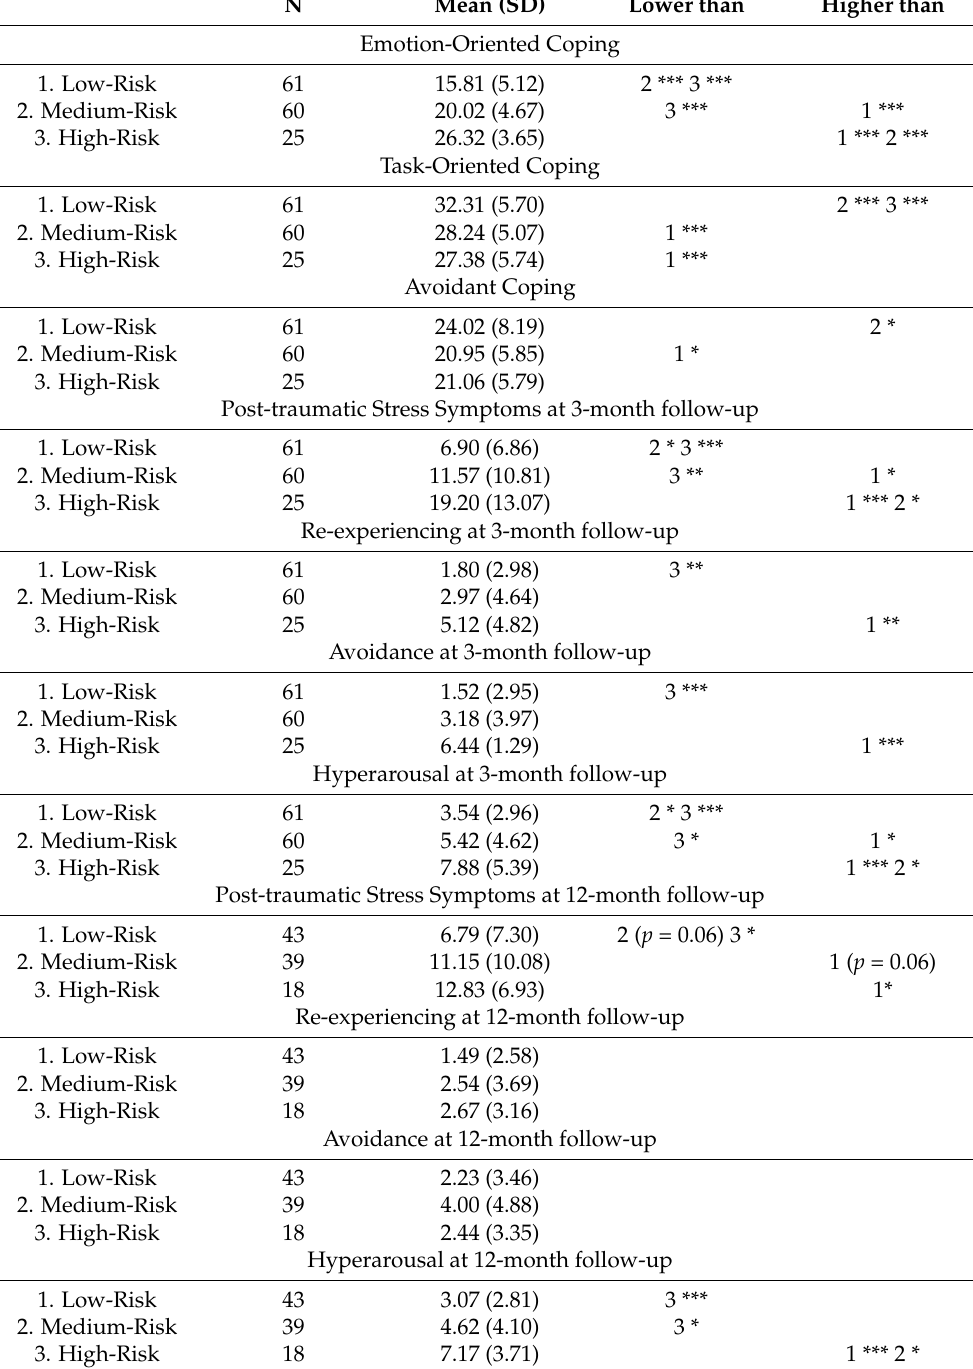
Table 3. Emotion-Oriented, Task-Oriented and Avoidant Coping at 3-month follow-up, and Post- traumatic Stress Disorder Symptoms and each subscale of Post-traumatic stress Disorder symptoms at 3-month and 12-month follow-up by cluster